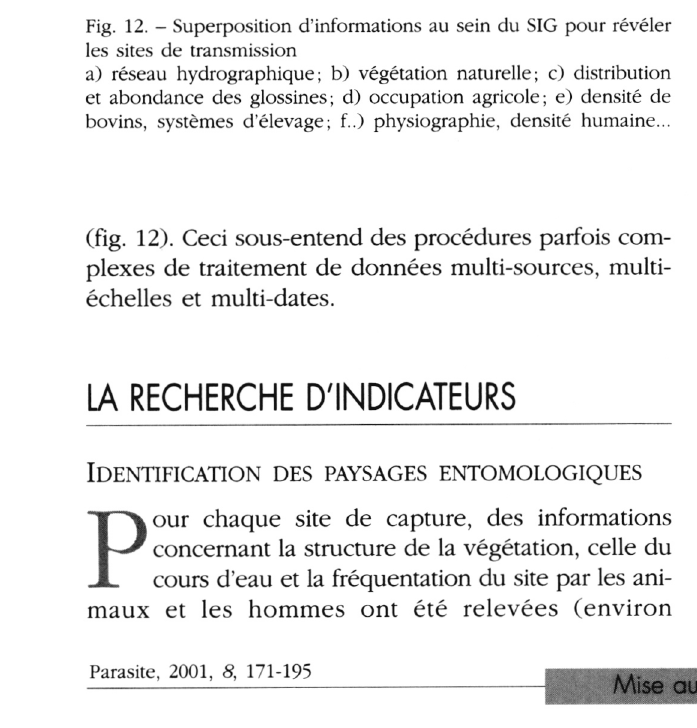
Fig. 12. - Superposition d’informations au sein du SIG pour révéler les sites de transmission a) réseau hydrographique; b) végétation naturelle; c) distribution et abondance des glossines; d) occupation agricole; e) densité de bovins, systèmes d’élevage; f..) physiographie, densité humaine...